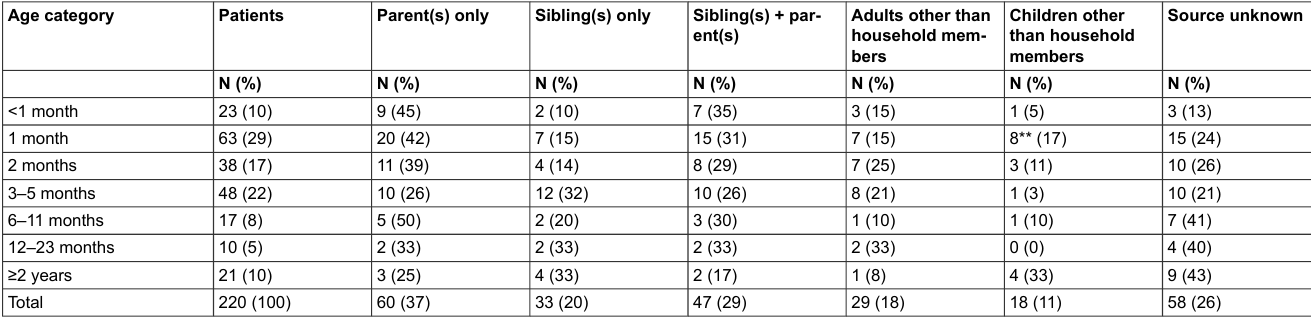
Table S7: Source of infection* Age category